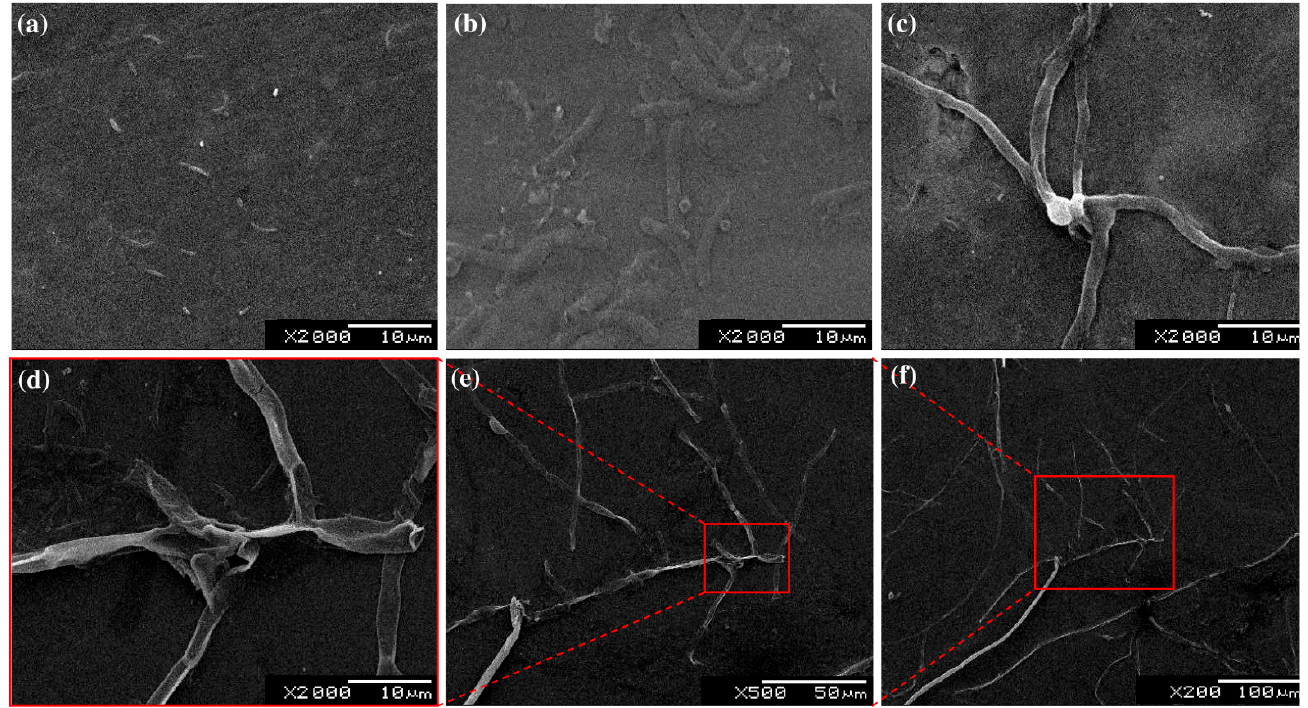
Figure 10. SEM images of: ( a ) untreated Ti; SMAT-modified samples treated for: ( b ) 15 min; ( c ) 20 min and ( d ) 25 min showing deposit of non-toxic salts from ringer lactate solution at reactive grain boundaries; ( e , f ) are zoomed-out images of ( d ) showing network of salt deposits in the vicinity.